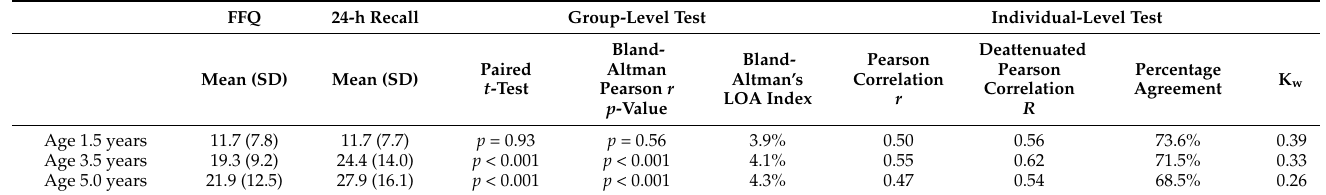
Table 2. Group-level and individual-level comparison of energy-adjusted free sugars intake (g/d) estimated by food frequency questionnaire (FFQ) and three 24-h recalls at ages 1.5, 3.5, and 5.0 years 1 .